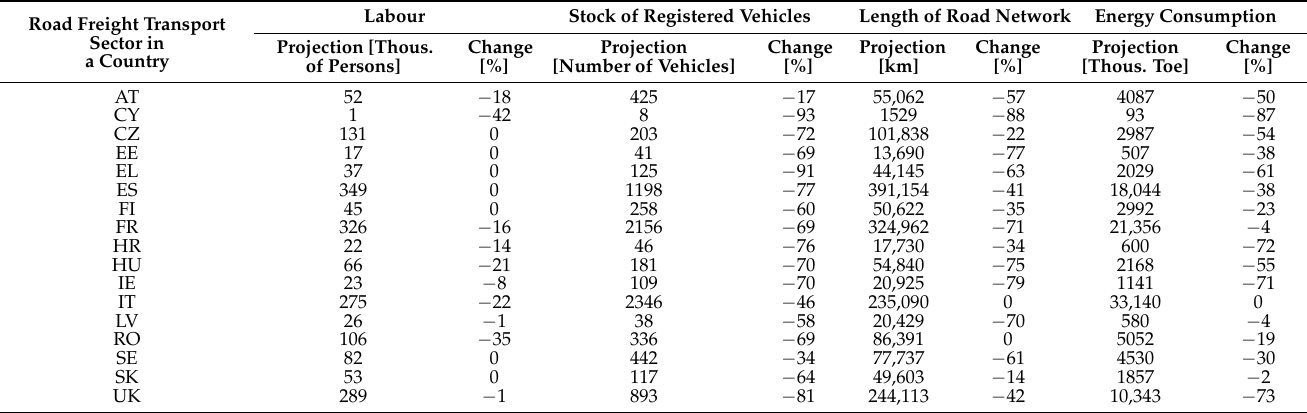
Table 5. Summary of average excess in